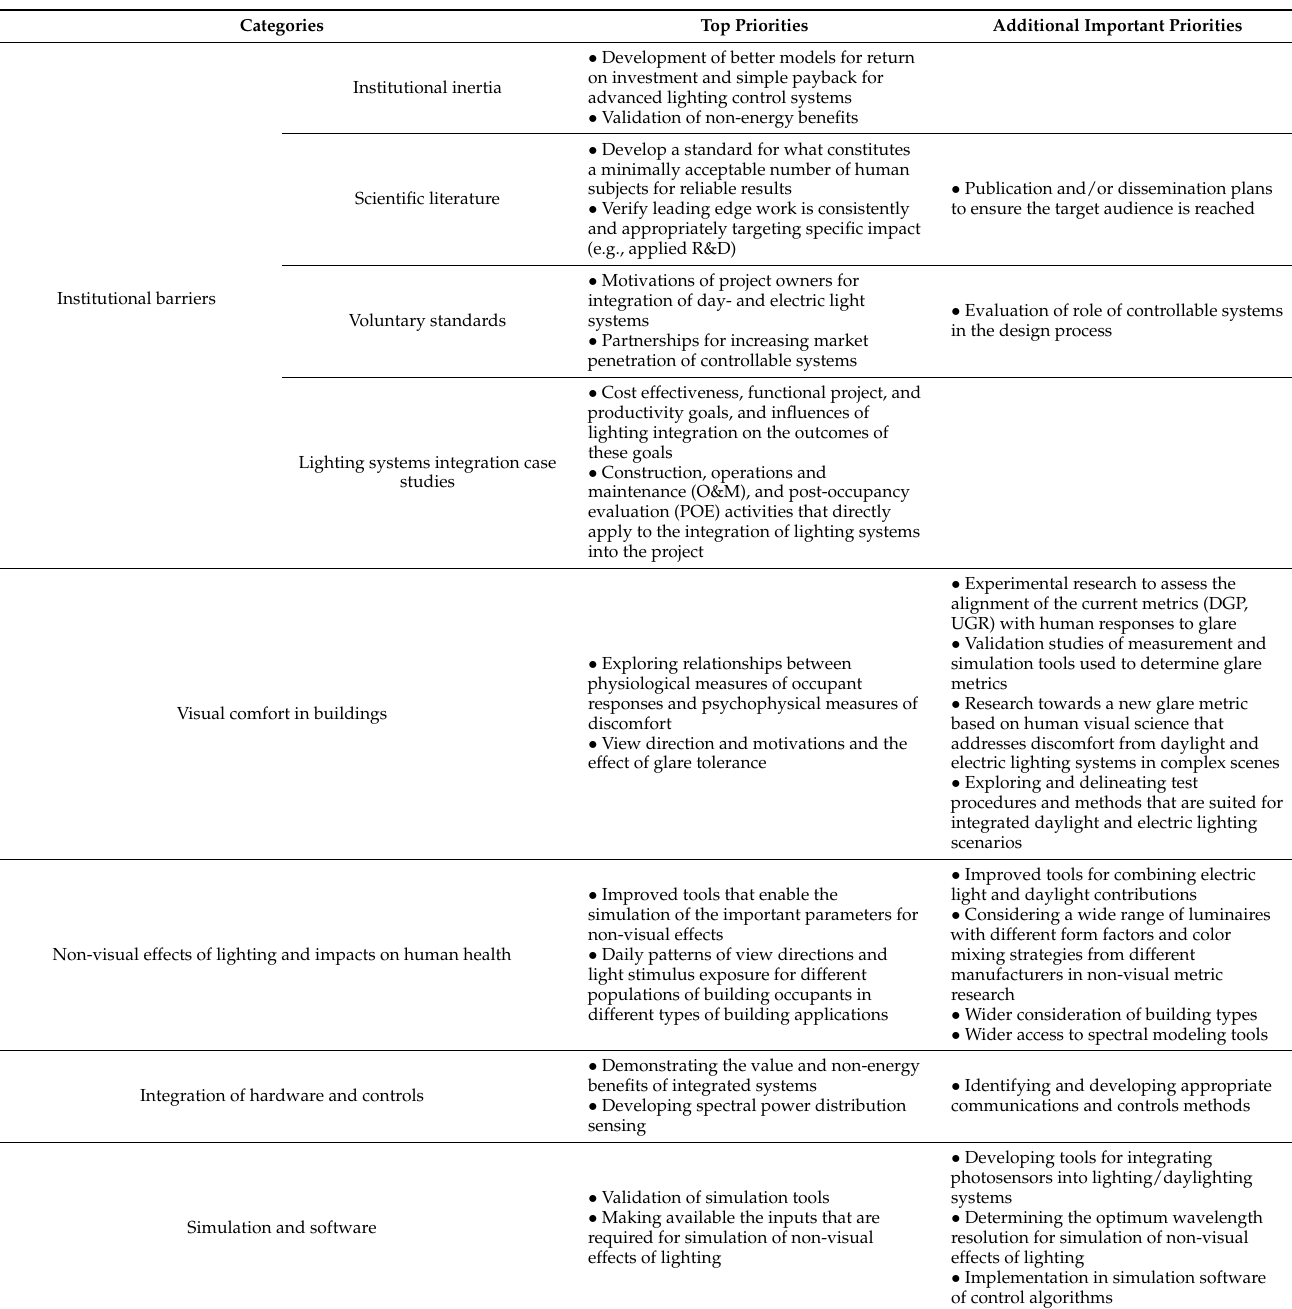
Table 1. Research topics identified as priorities for achieving deeper integration between electric lighting and daylighting